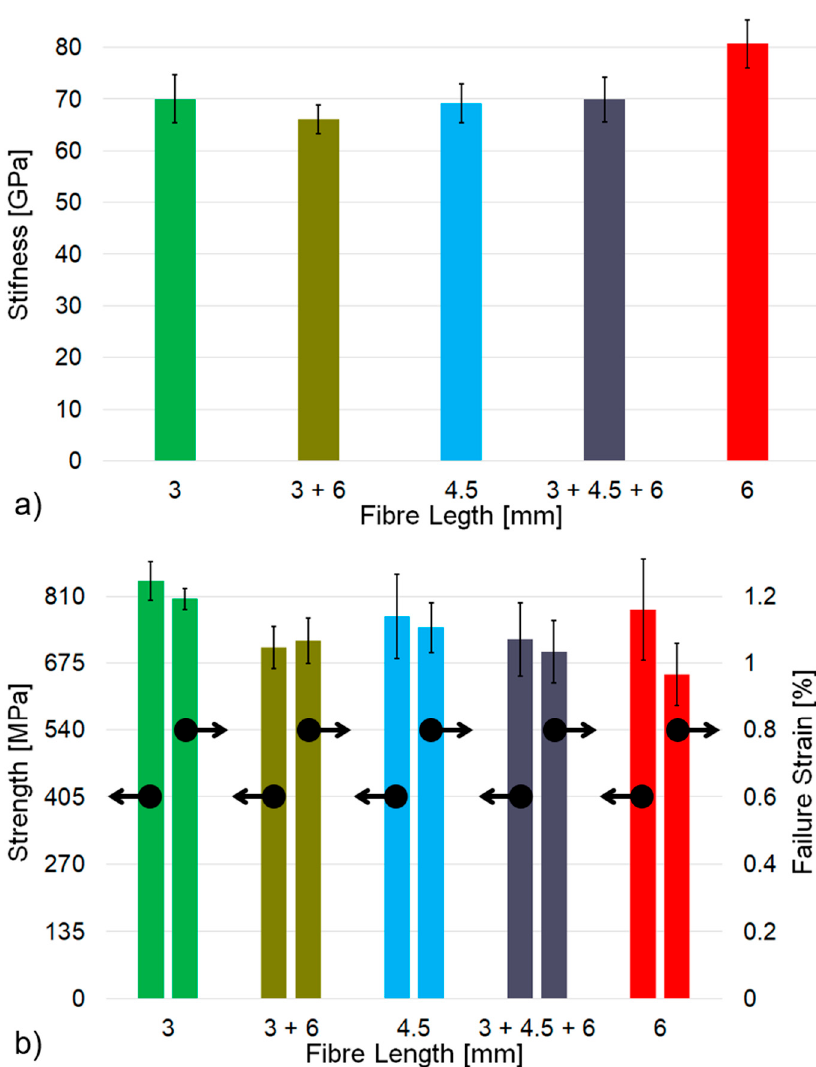
Figure 5. Material property summary: ( a ) Tensile modulus; ( b ) Tensile strength and Failure Strain.